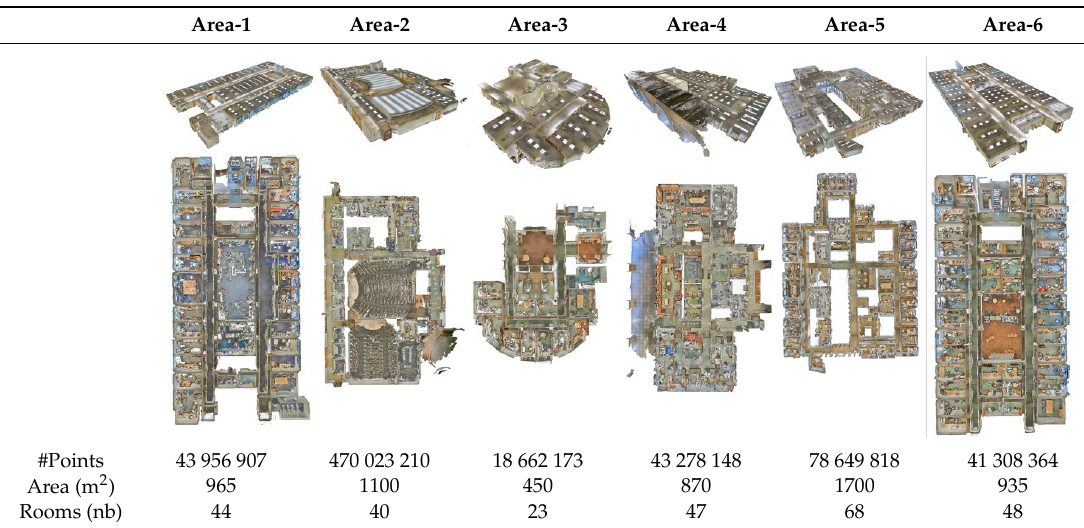
Table 4. The S3DIS dataset and its six areas used for testing our methodology. Table 4: The S3DIS dataset and its six areas used for testing our methodology.